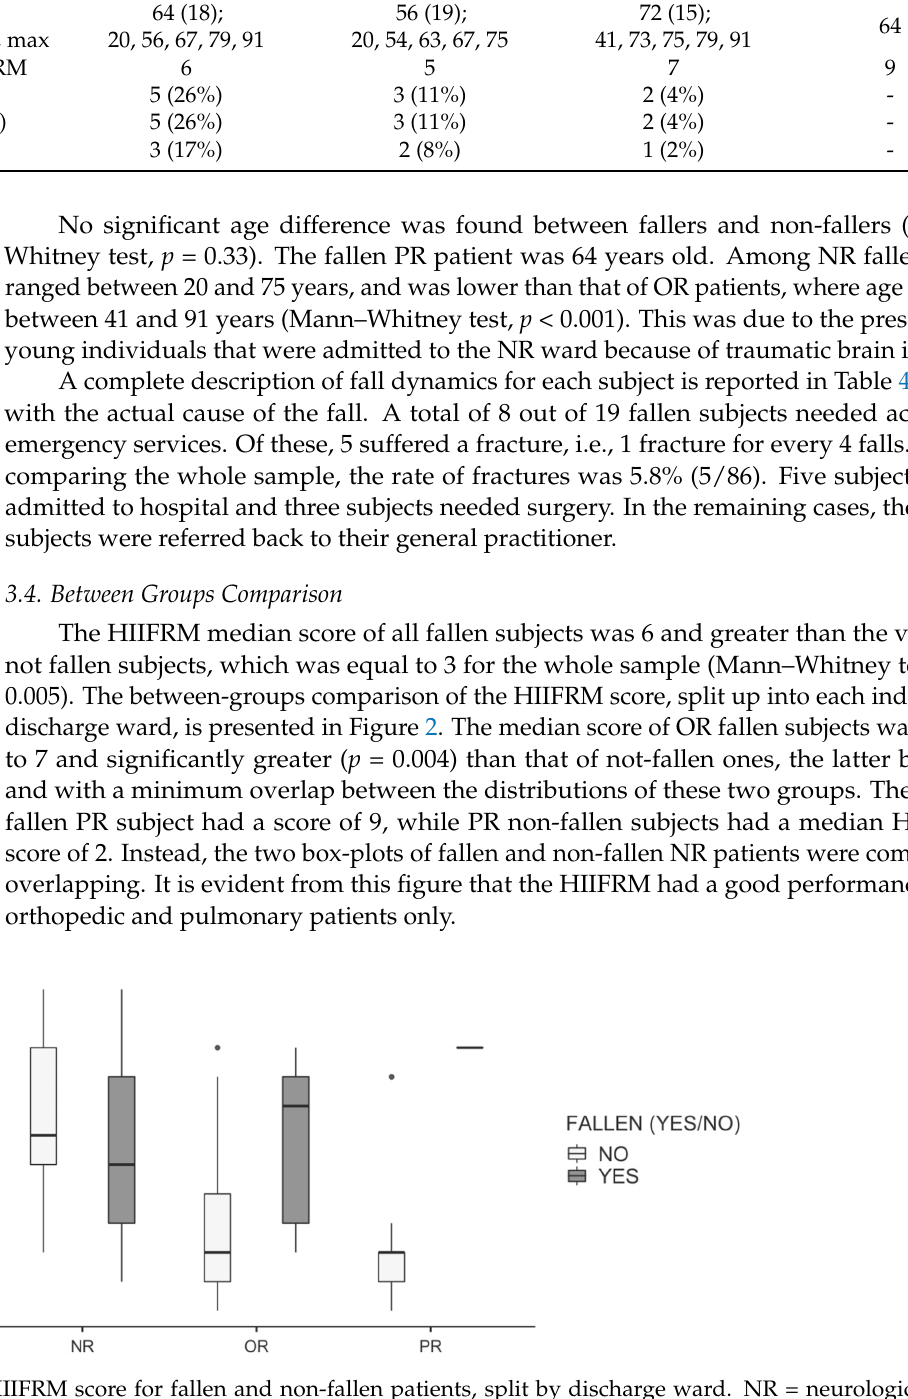
Figure 2. Boxplot of the HIIFRM score for fallen and non-fallen patients, split by discharge ward. NR = neurological reha- bilitation; OR = orthopedic rehabilitation; and PR = pulmonary rehabilitation.